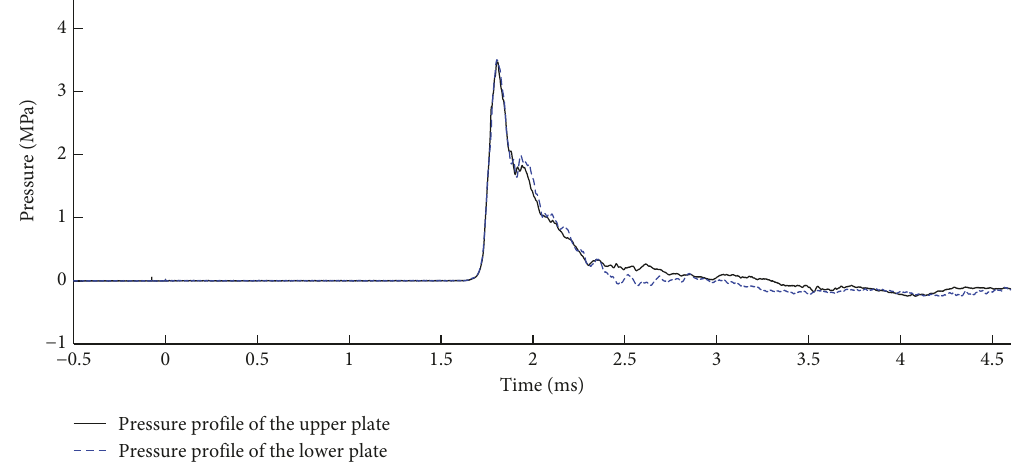
Figure 7: The comparison between pressure-time profiles of the upper and lower target plates.